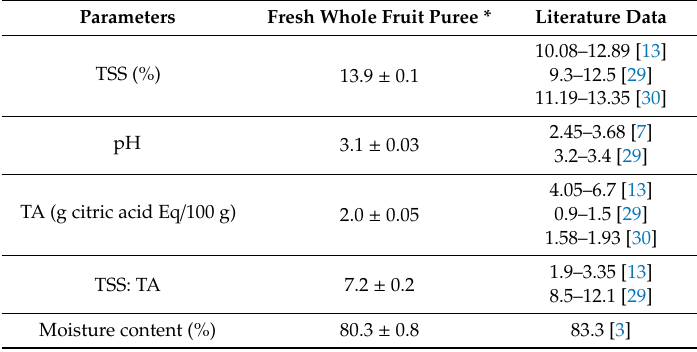
Table 1. Physico-chemical parameters of fresh feijoa whole fruit